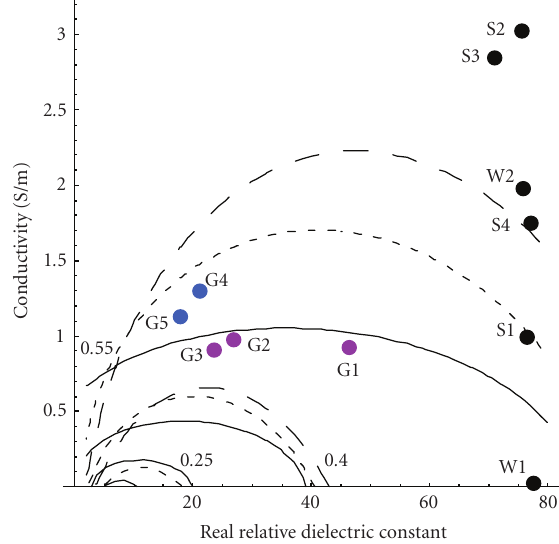
Figure 6: Low-frequency detail of Figure 5, for 400 MHz (solid curves), 900 MHz (dotted curves), and 1.3 GHz (dashed curves) re- flection magnitude contours of 0.25, 0.4, and 0.55. Labeled points indicate particular bolus fluids: W1: water at 300 MHz, W2: water at 3GHz, S1: 0.1 molal saline at 300 MHz, S2: 0.1 molal saline at 3 GHz, S3: 0.3 molal saline at 300 MHz [16], S4: 0.15 molal (0.9%) saline at 900 MHz, G1: 10 : 30 glycerin/water at 900MHz, G2: 80 : 20 glycerin/water at 900MHz, G3: 87 : 13 glycerin/water at 900 MHz, G4: 79 : 21 glycerin/water at 1.3GHz, and G5: 87 : 13 glycerin/water at 1.3GHz